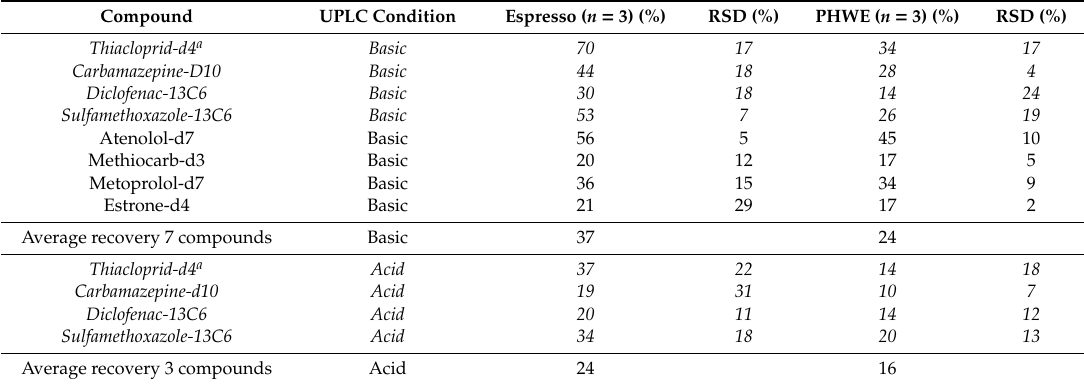
Table 1. Absolute recovery and relative standard deviation (RSD %, n = 3) for the instrumental standard thiacloprid-d4 spiked just prior to the analysis and seven labelled standards spiked at the top of the two types of extraction cells, Espresso and PHWE, containing the sewage sludge. Absolute recovery was calculated using Equation (1). Four of the compounds were analysed at both basic and acid conditions and are marked in italic